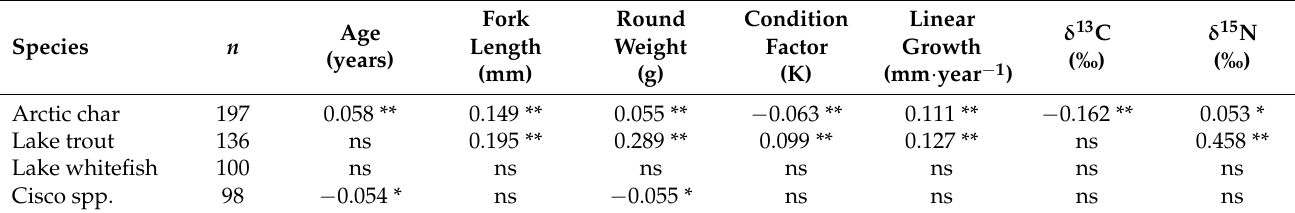
Table 4. Coefficient of determination (r 2 ) showing the proportion of variation in soft tissue selenium concentrations in relation to age, fork length, body weight, condition, and linear growth, as well as stable carbon and nitrogen isotopes with statistical significance of the regressions, noting that negative relationships are indicated by a minus